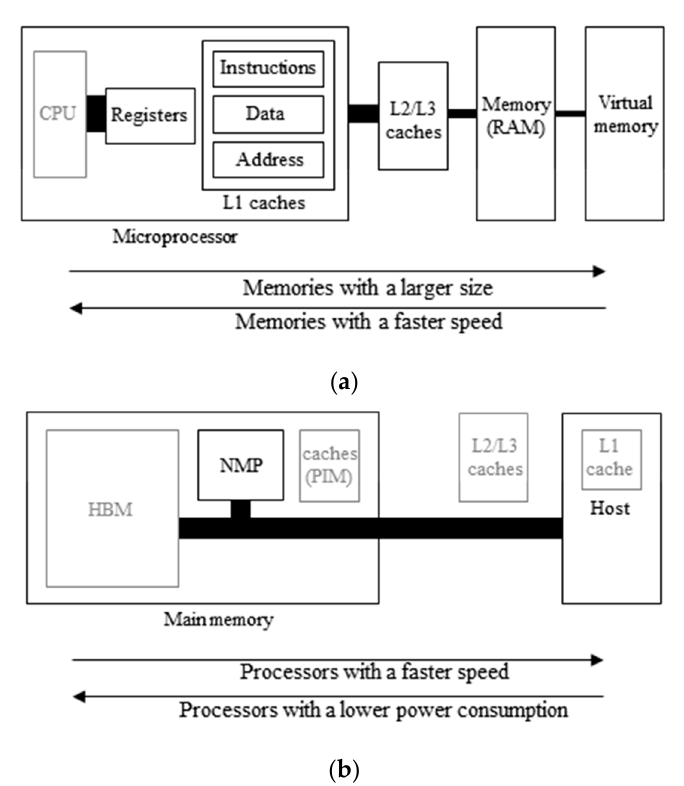
Figure 1. Processor-centered and memory-centered approaches to overcome the memory bottleneck, ( a ) deep memory hierarchy, and ( b ) processor hierarchy.